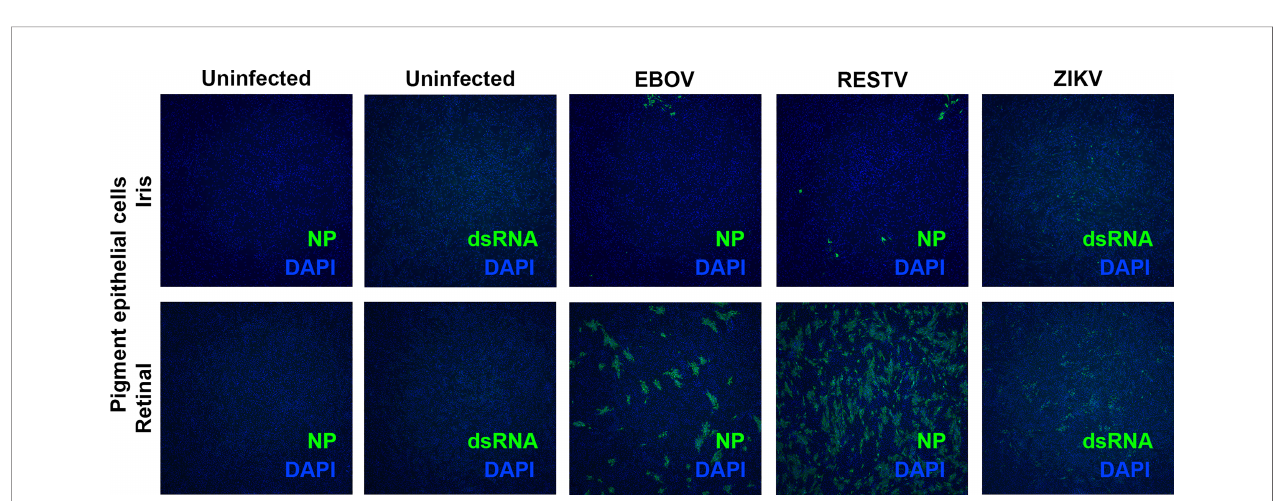
FIGURE 3 | Representative fl uorescence photomicrographs of EBOV-, RESTV- and ZIKV-infected, plus uninfected donor-matched human iris and retinal pigment epithelial cell monolayers 48 hours following inoculation at a multiplicity of infection of 1 immunolabelled to detect ebolavirus nucleoprotein (EBOV and RESTV) or double-stranded RNA (ZIKV). Alexa Fluor 488 (green) with DAPI nuclear counterstain (blue). Original magni fi cation: 10x.